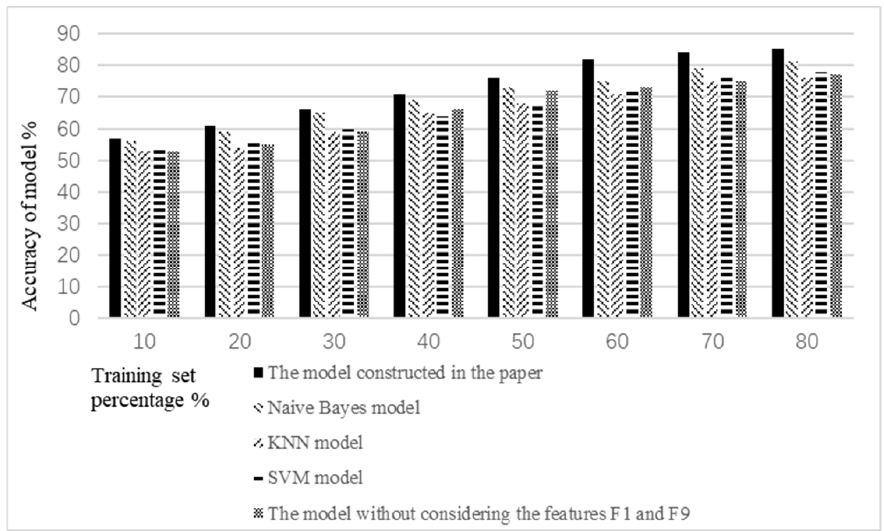
Figure 8. The accuracy comparison of the five models.